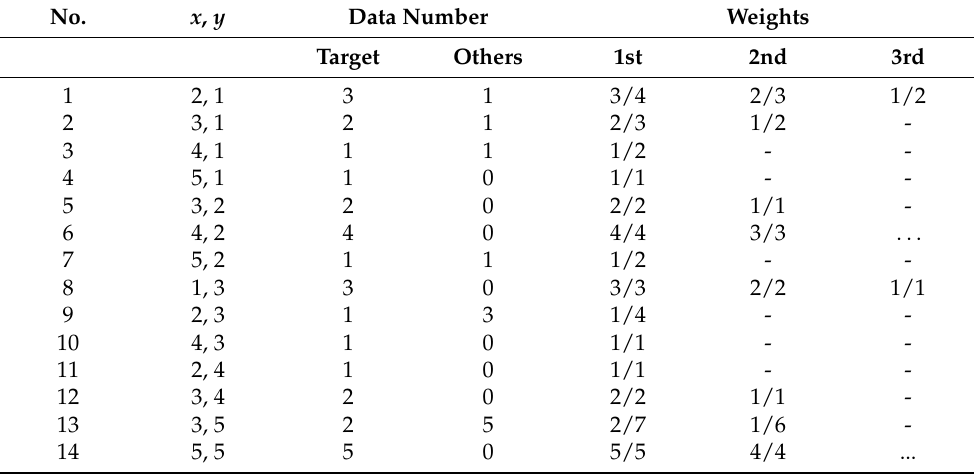
Table 2. Data selection process based on high-distribution consistency (DC) and low DC.